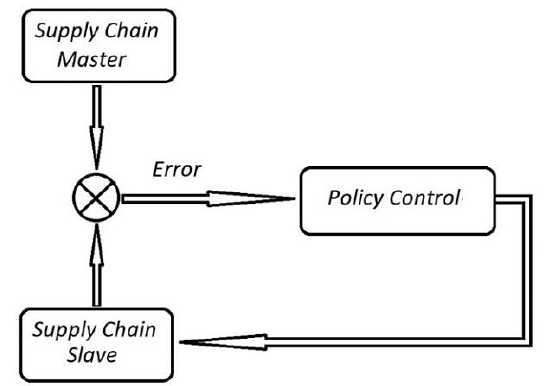
Fig. 3. The concept of chaos